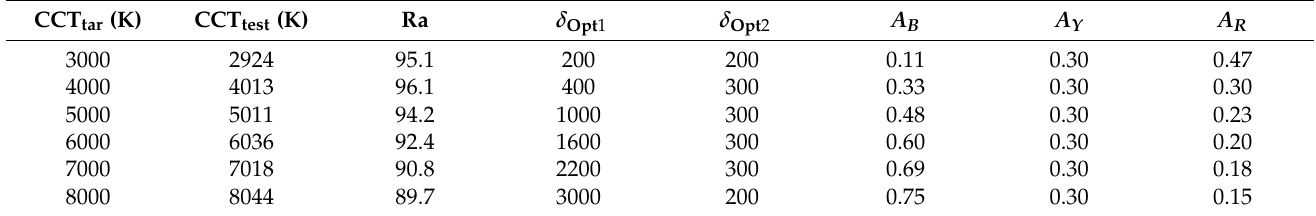
Table 1. Calculation parameters of spectral optimization using the proposed method.